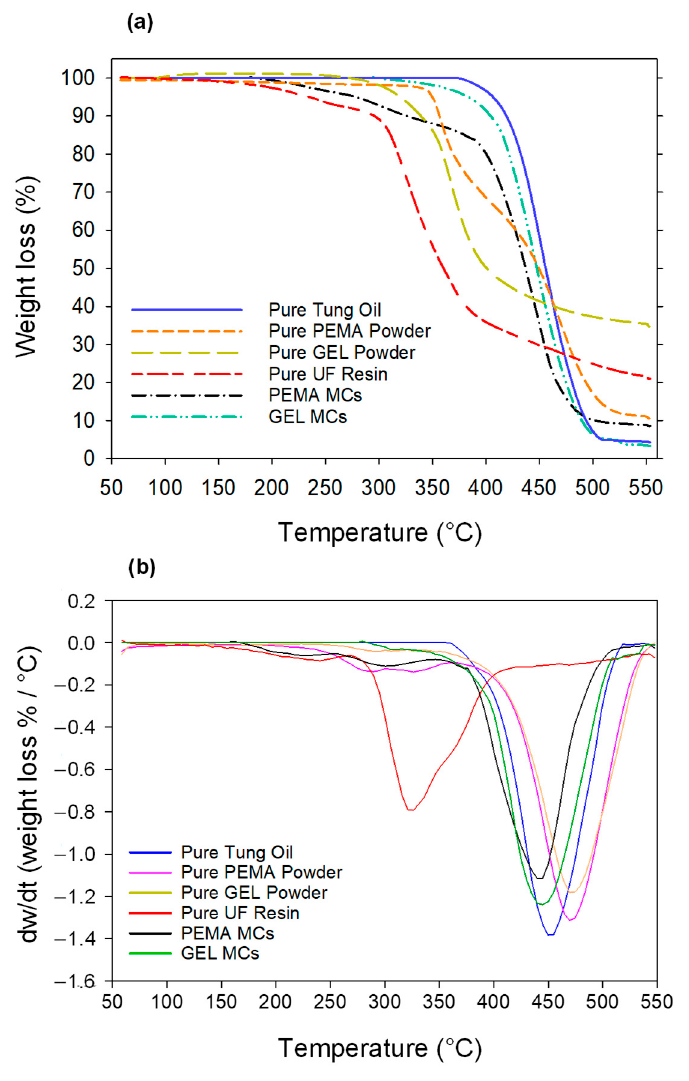
Figure 7. ( a ) TGA plot and ( b ) the derivative weight change for the pure tung oil, pure PEMA powder, pure Gel powder, pure UF resin, PEMA microcapsules and GEL microcapsules.